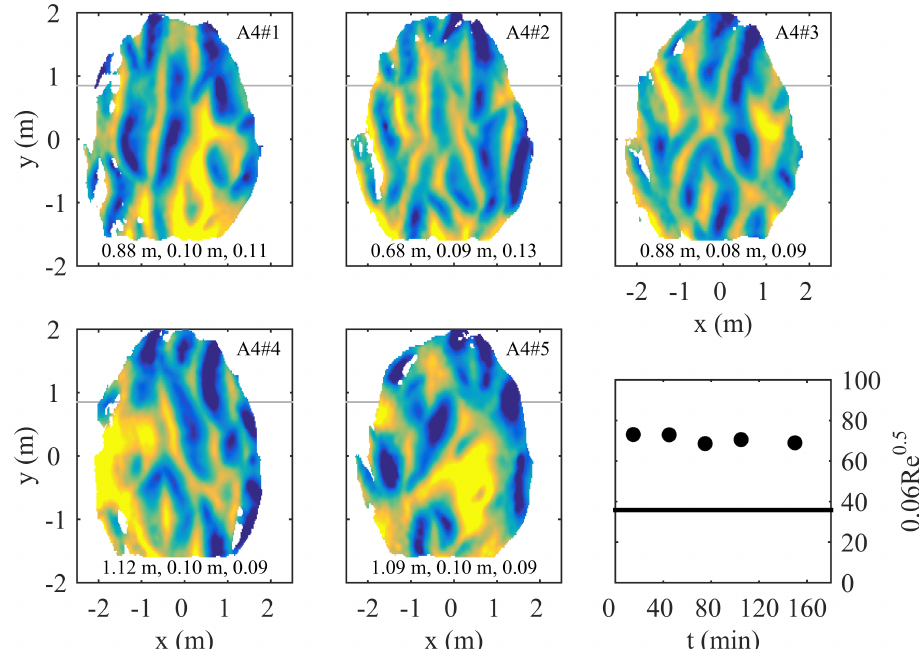
Figure 10. Bed elevation models for all five runs in test A4. For additional explanation,